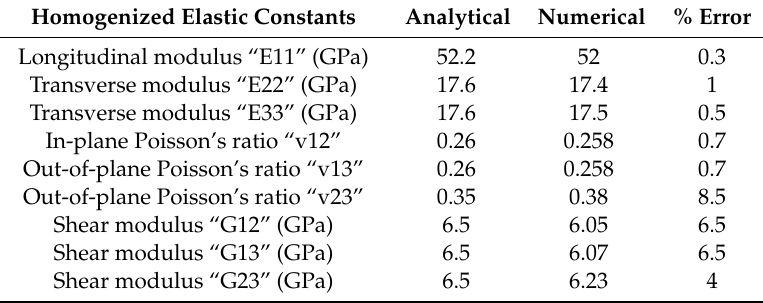
Table 6. Summary of elastic constants (impregnated yarns).